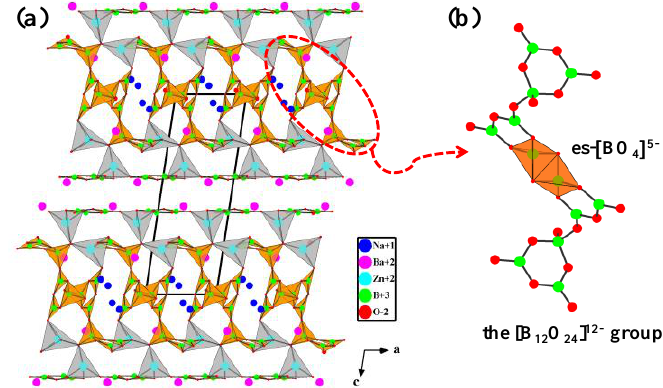
Figure 7. ( a ) The crystal structure of Ba 4 Na 2 Zn 4 (B 3 O 6 ) 2 (B 12 O 24 ) viewed along the b -axis; ( b ) the [B 12 O 24 ] 12 − group containing es − [BO 4 ] 5 − tetrahedra. Adapted from Ref. [75], Copyright (2013) with permission from Elsevier.